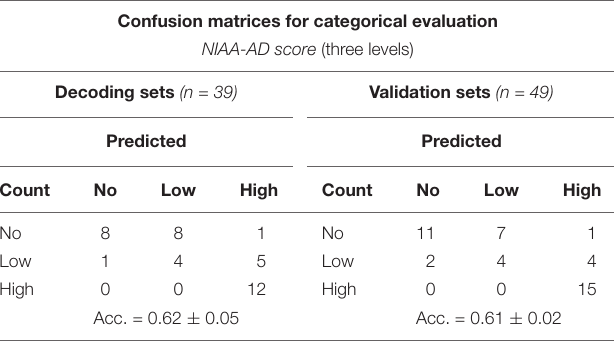
TABLE 4 | Categorical evaluation of RandomForest (RF) prediction models. Confusion matrices for categorical evaluation